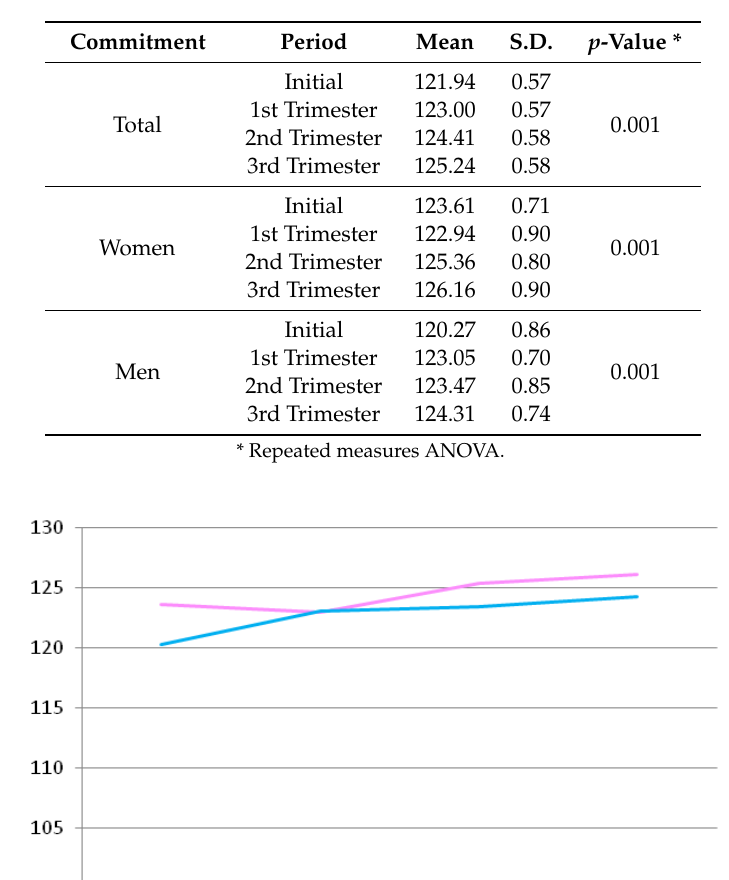
Table 11. Initial and final Commitment means for each trimester.